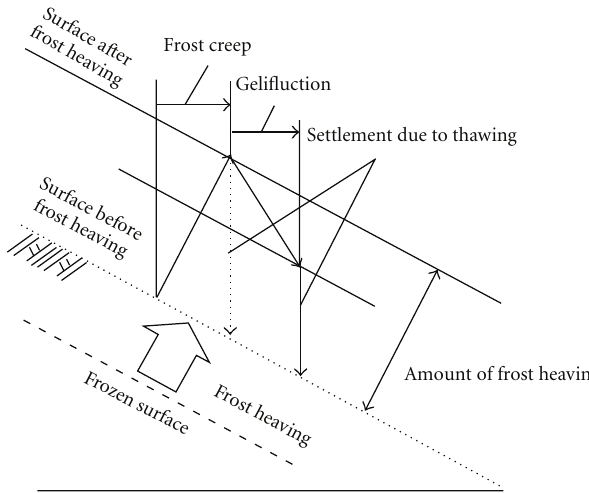
Figure 14: Solifluction process composed of “frost creep” and “gelifluction”.